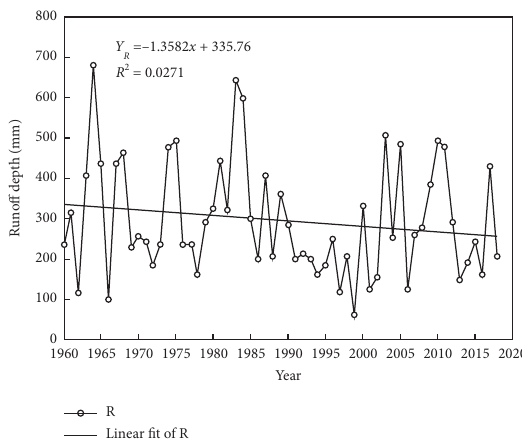
Figure 2: The variation in R in the Yue River watershed during